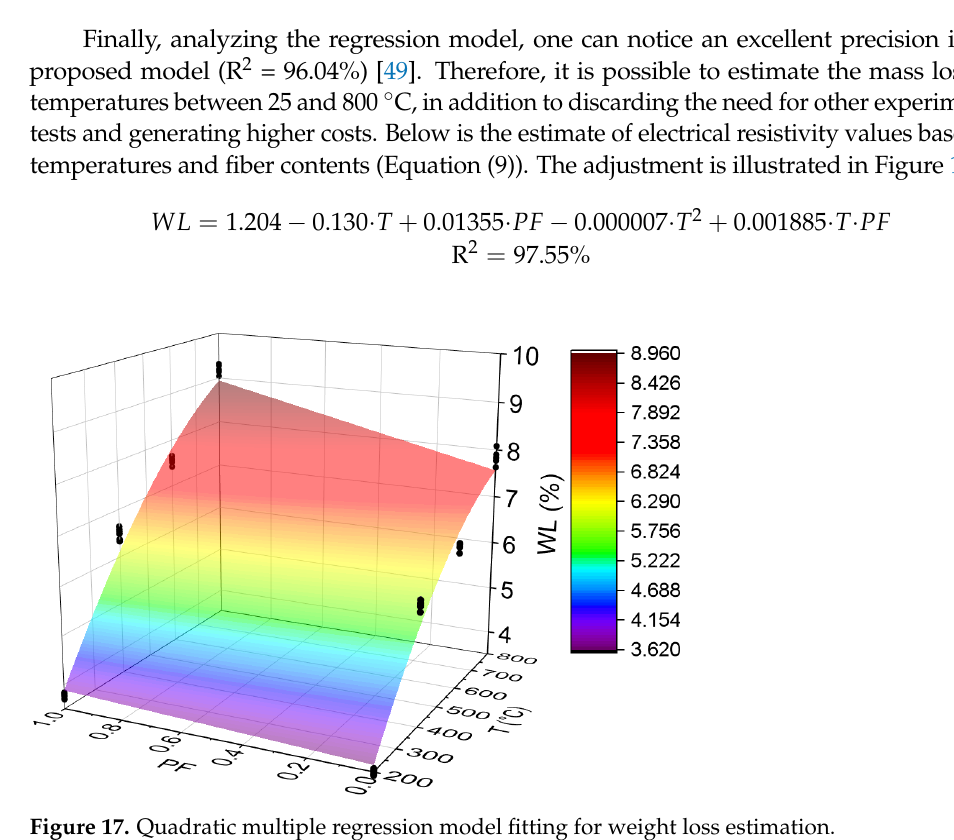
Figure 16. Summary of weight loss (WL) results: ( a ) Tukey’s test for the samples without polypropy- lene fibers, ( b ) Tukey’s test for the samples with polypropylene fibers, ( c ) Tukey’s test for the samples without and with polypropylene fibers and ( d ) Quadratic regression model fit to the experimen- tal data set considering only the effect of temperature as an independent factor. The uppercase letters A–D in figure mean equivalence between the sample results.